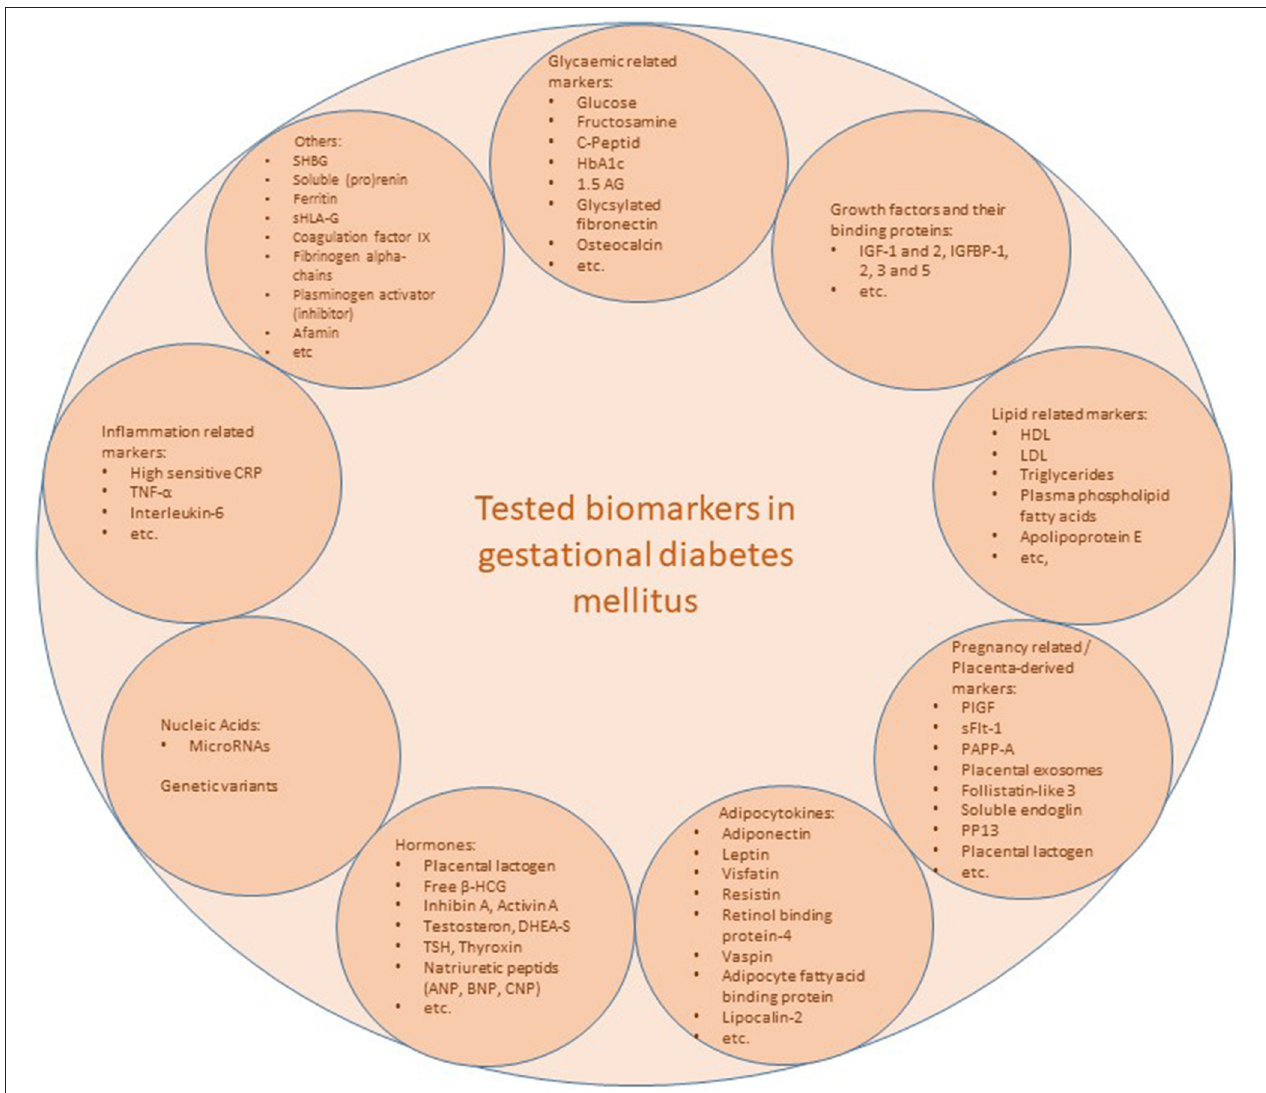
FIGURE 1 | Overview of tested biomarkers. CRP, c-reactive protein; Free β -HCG, free β -human chorionic gonadotropin; GlyFn; glycosylated fibronectin; HbA1c, hemoglobin A1c; HDL, high density lipoprotein; hsCRP, high sensitive c-reactive protein; IGF, insulin like growth factor; IGFBP, insulin like growth factor binding protein; LDL, low density lipoprotein; MF, maternal factors; PAI-2, plasminogen activator inhibitor-2; PP13, placental protein 13; PAPP-A, pregnancy associated plasma protein-A; PlGF, Placental growth factor; microRNAs, micro ribonucleic acids; sFlt-1, soluble Fms-like tyrosine kinase-1; SHBG, sexual hormone binding